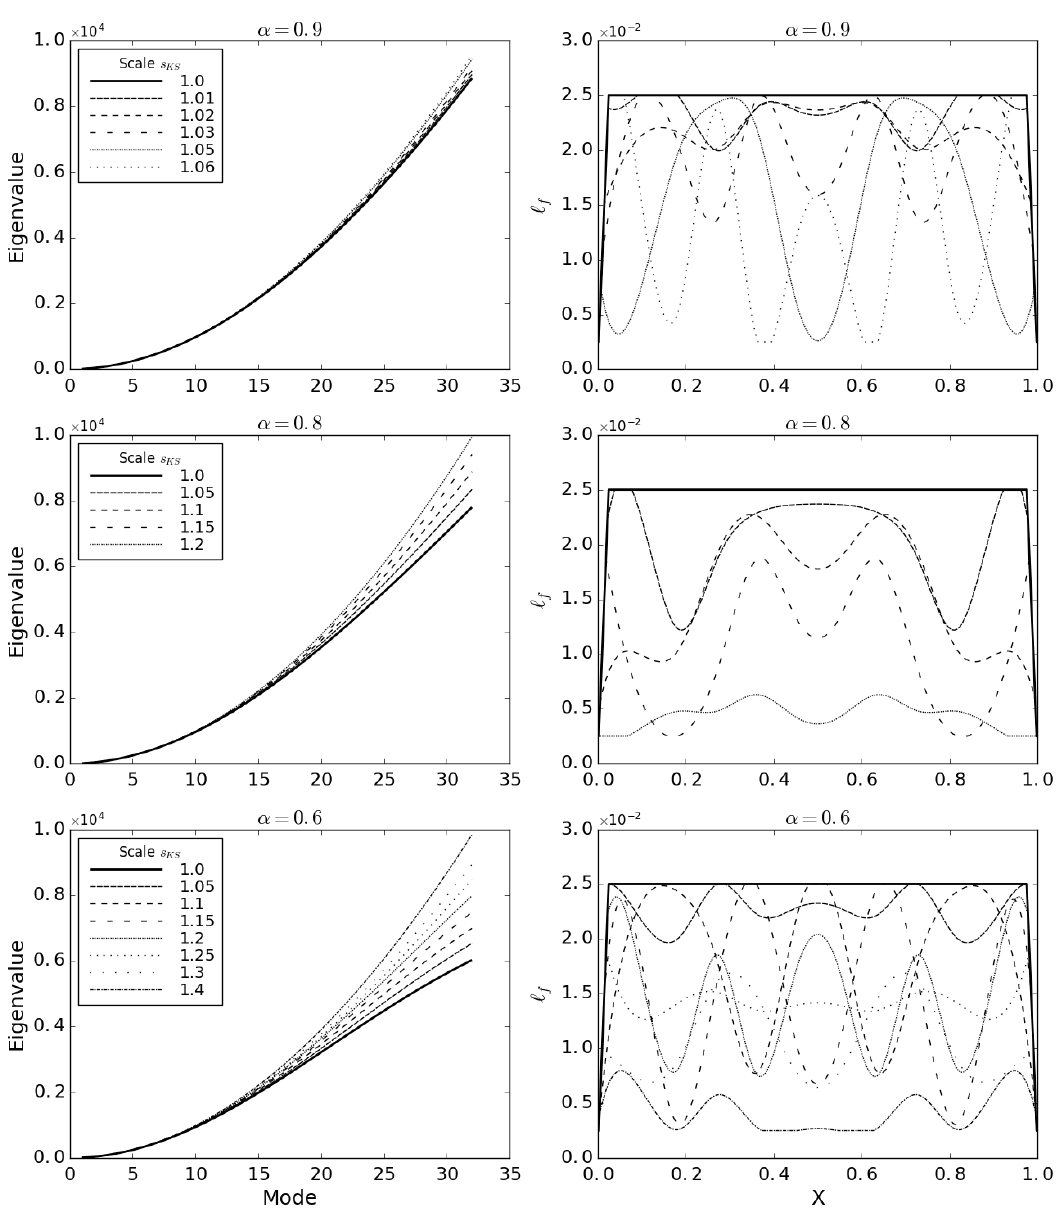
Figure 5. Eigenvalues ( left column ) and corresponding length scale distributions ( right column ) for particular material orders α ∈ { 0.6,0.8,0.9 } and (cid:96) f =